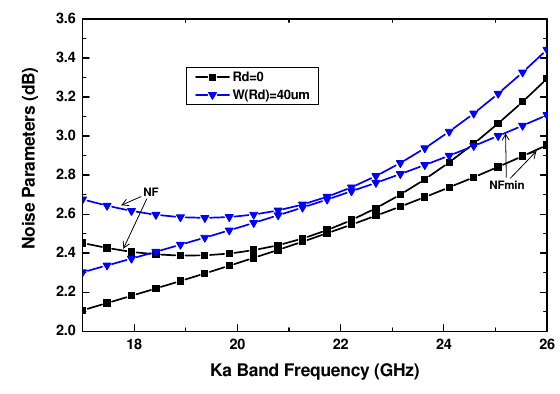
Figure 7. Noise contributions of the tank impedance (in terms of NF and